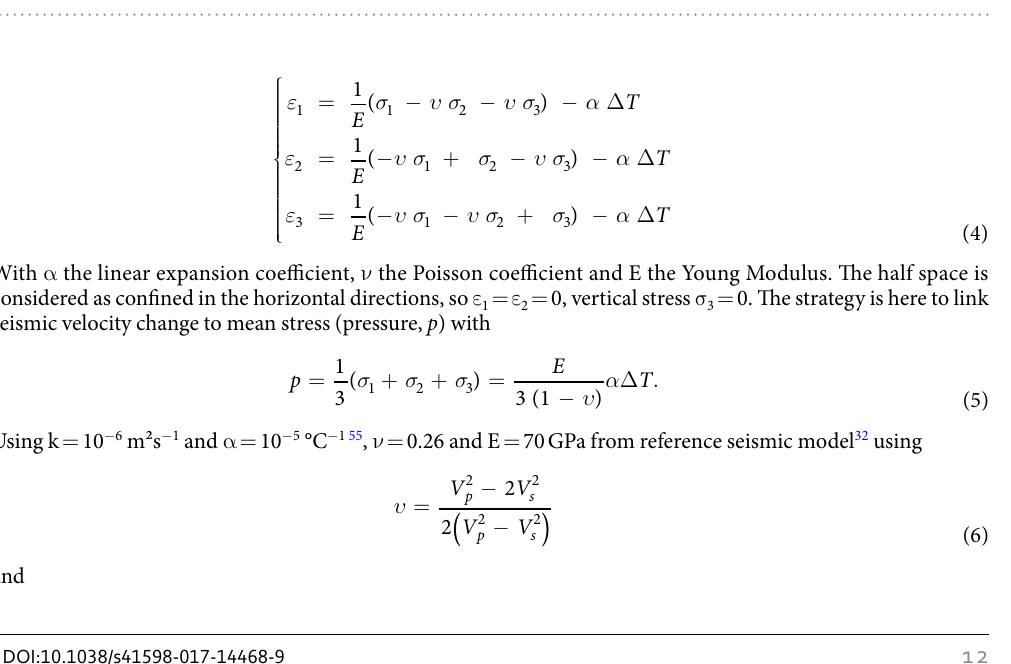
Figure 12. Thermoelastic stress processing scheme: ( A ) observed monthly (blue) and annual (red) mean surface temperature variations; ( B ) modeled temperature diffusion and ( C ) associated thermoelastic pressure change as a function of depth and time. The colorscale of B is saturated to highlight deep temperature diffusion. ( D ) Modeled average pressure change (blue). The long-term variation (red) is calculated as 12-month running mean and is reported as the modeled relative thermoelastic pressure variation dp t